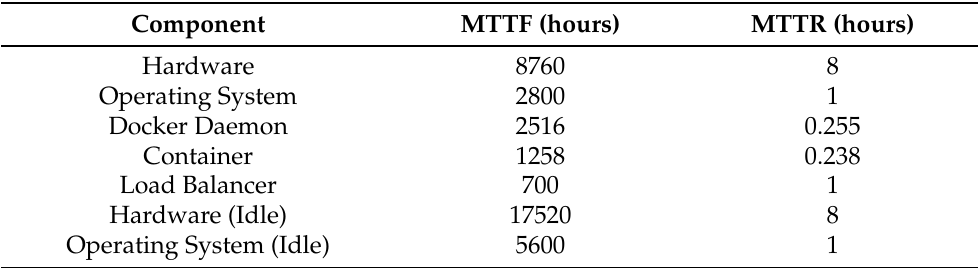
Table 7. Extended model input values.